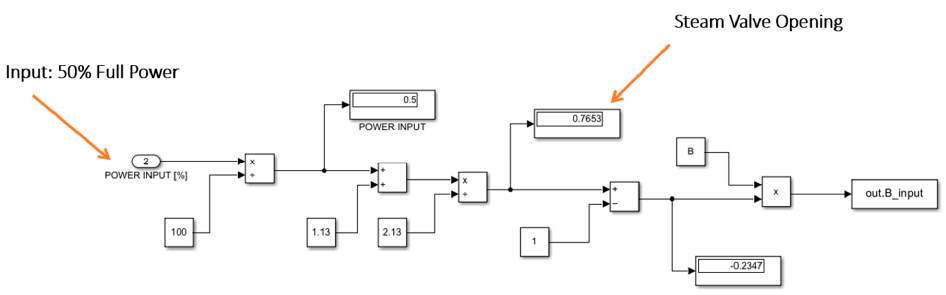
Figure 14. Input system: power rate and steam valve opening.